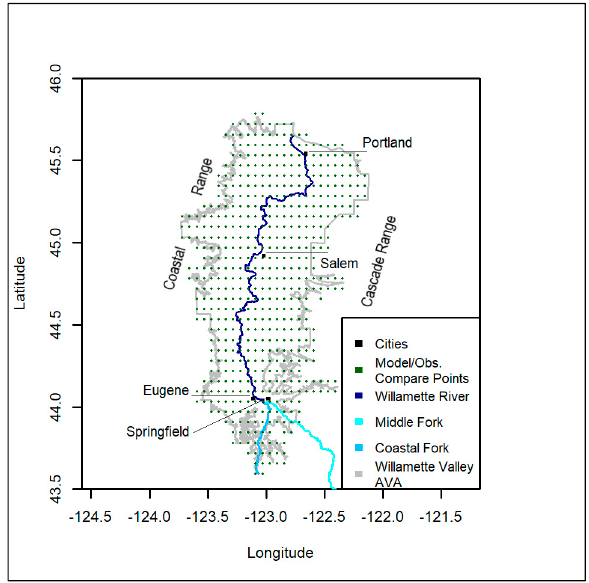
Figure 1. The 553 model-observation data locations which cover the Willamette Valley American Viticultural Area (AVA) used to compute prediction specific model-to-measurement misfit evalua- tions and ensemble composition and weights assignments by comparing bioclimatic index relevant processed daily Localized Constructed Analogs (LOCA) Coupled Model Intercomparison Project phase 5 (CMIP5) model historic datasets [40,41] with their equivalently processed observed data counterparts [18,42].